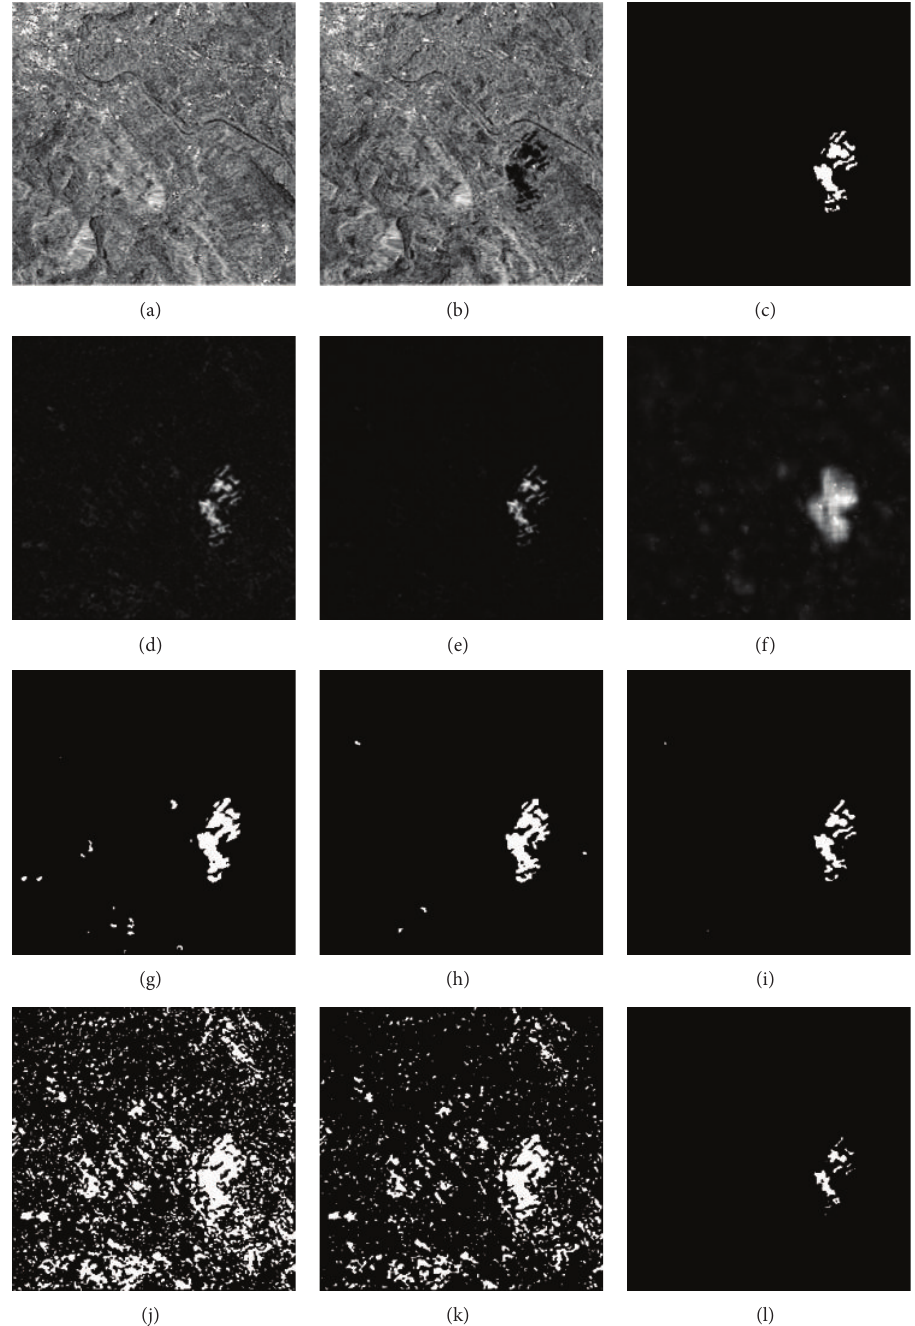
Figure 2: Experimental results on Bern dataset. (a) Image acquired in April 1999, (b) image acquired in May 1999, (c) ground truth, (d) LR DI, (e) NLR DI, (f) CKLD DI, (g) change map by CWT-EM, (h) change map by MRF-FCM, (i) change map by MSRM, (j) change map by LR-GKIT, (k) change map by NLR-GKIT, and (l) change map by GR-HRT.